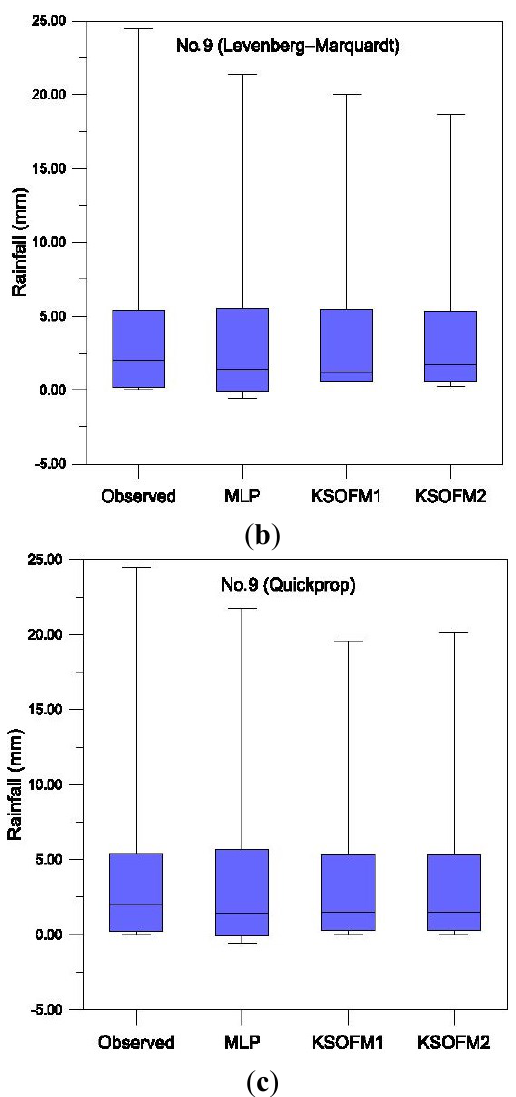
Figure 10. Rainfall box plots for Hwasu (No.9) station (test period). ( a ) Conjugate gradient; ( b ) Levenberg–Marquardt; ( c )